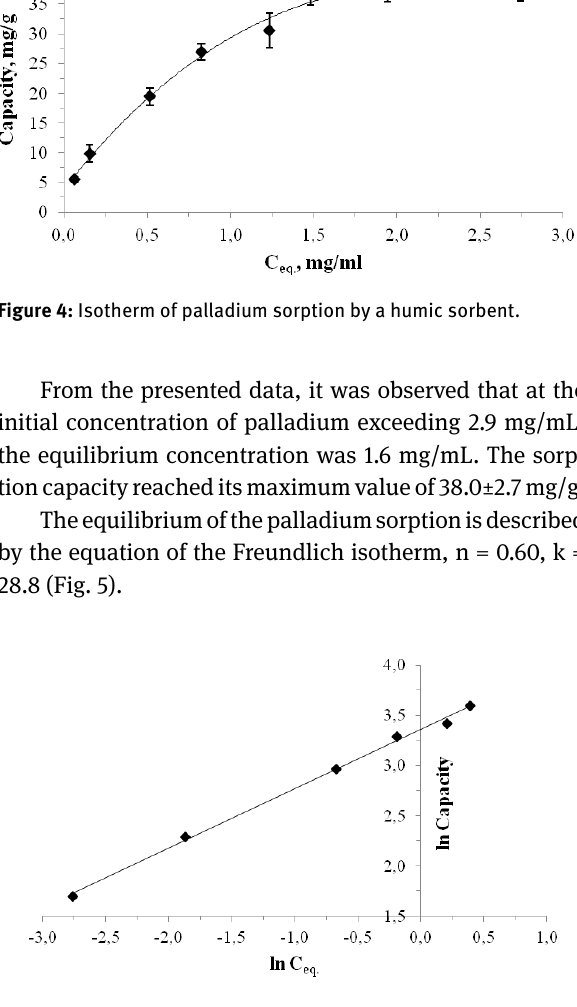
Table 1: Dependence of the sorption of [PdCl 4 ] 2− ions on a humic sorbent on time